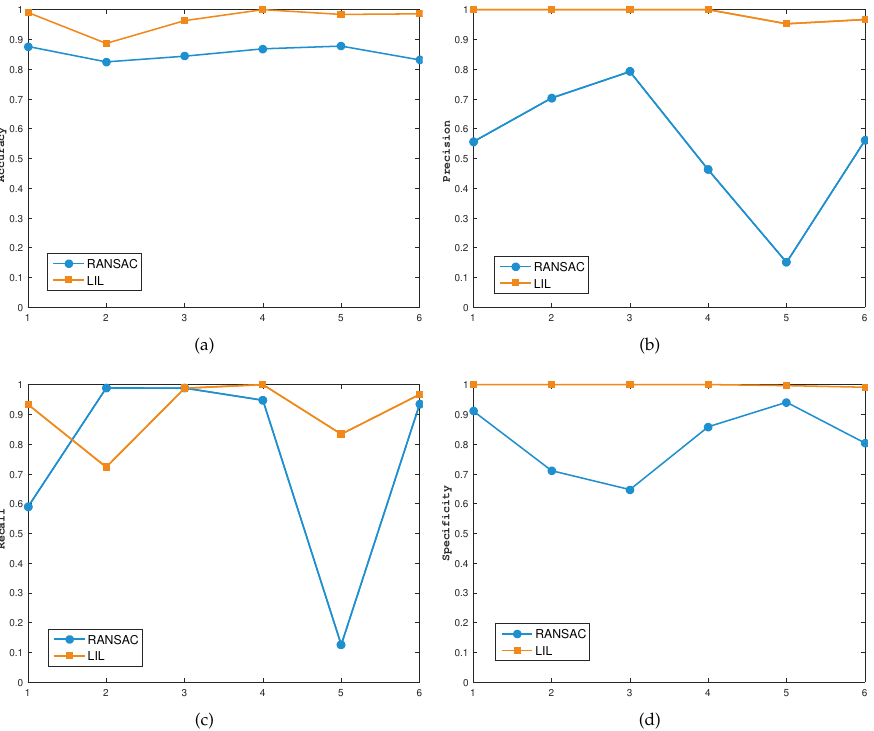
Figure 15. Performance comparison of RANSAC and LIL outlier removal on real remote sensing images. ( a ) Accuracy; ( b ) Precision; ( c ) Recall; ( d ) Specificity.